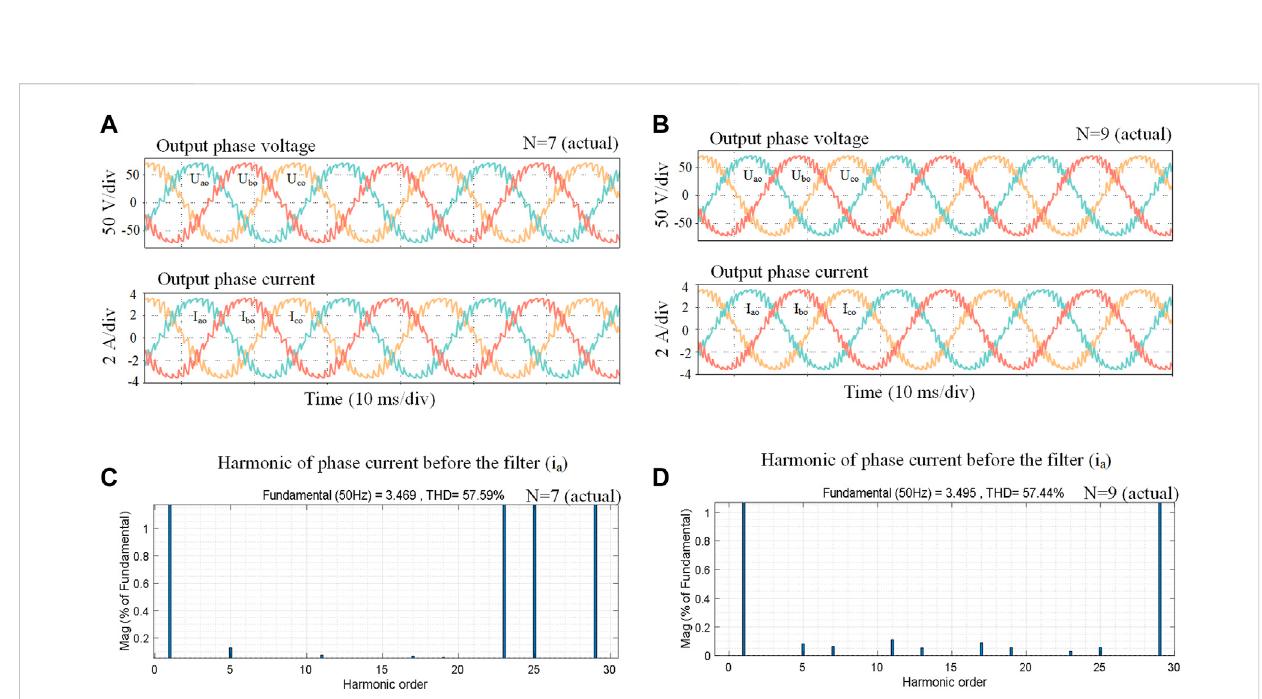
con fi guration scheme as the conventional CSI. The key difference is that the seventh switch uses a high-performance power switch. This seventh switch should be characterized by high switching frequency and low loss, which can increase the inverter commutation speed